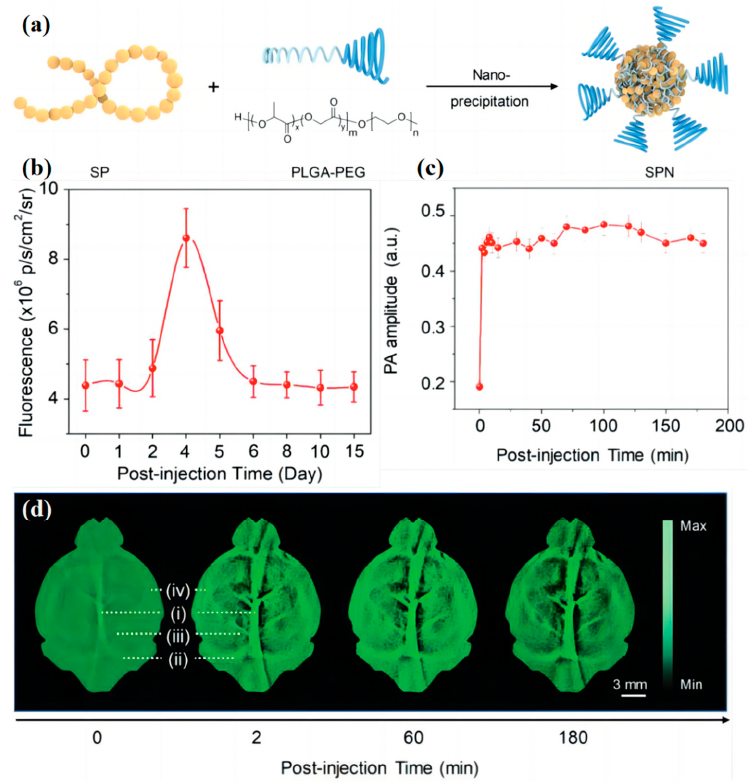
Figure 8. ( a ) Scheme of preparation of NIR-II PA SPNs via nanoprecipitation. Adapted with per- mission from [125]. ( b ) Quantification of fluorescence intensities of the liver region in living mice as a function of post injection time. Adapted with permission from [125]. ( c ) Quantification of PA amplitudes of major blood vessels in panel. Adapted with permission from [125]. ( d ) PA images of brain vasculature at designated time points at 1064 nm after intravenous administration of SPN- PT (1.1 mg mL − 1 , 1 mL per rat) into living rats: ( i ) superior sagittal sinus; ( ii ) transverse sinus; ( iii ) vascular branches; and ( iv ) middle cerebral artery. Adapted with permission from